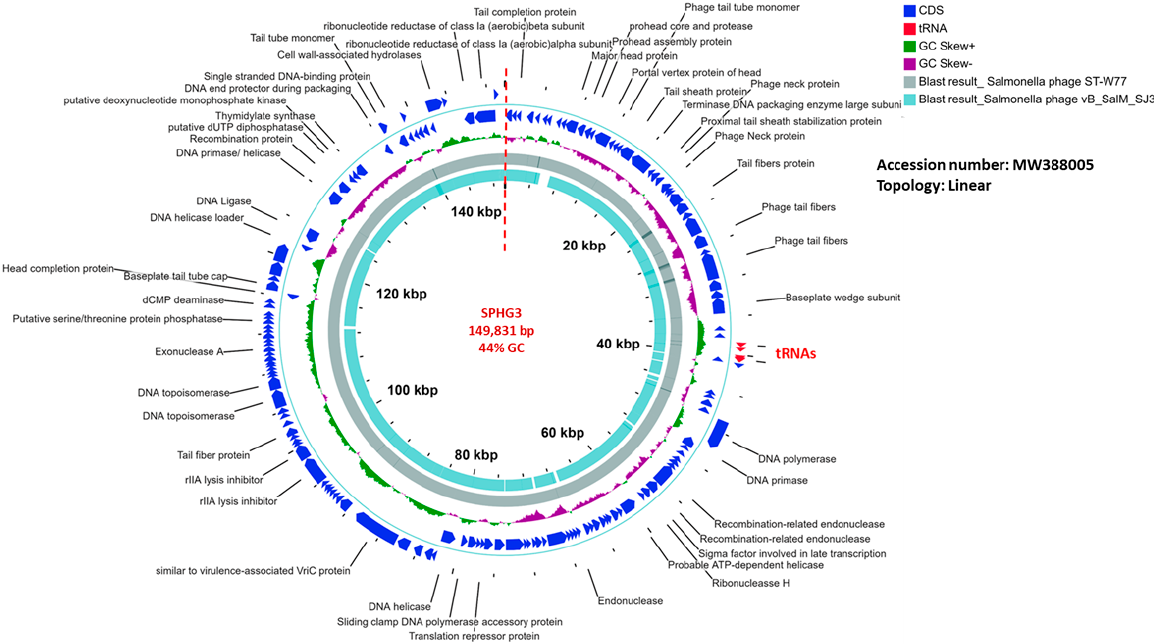
Figure 4. The SPHG3 genome organization represented as a circle. The 154 CDSs are represented as blue arrows showing the predicted genes transcribed clockwise (outer side) and counterclockwise (inner side) along the genome. Genes encoding tRNAs are represented as red arrows at about 3 o’clock in the genome. The genome map is circle, but there is a break at the 12 o’clock position (at the dotted straight red line) because the phage genome is a linear molecule. CDSs with known functions are labelled along with their position; however, other non-labelled CDSs represent hypothetical proteins. The following cycle is the GC content of the genome. The inner two circles represent the BLASTn alignment of SPHG3 against Salmonella phage ST-W77 and Salmonella phage vB_SalM_SJ3, respectively.